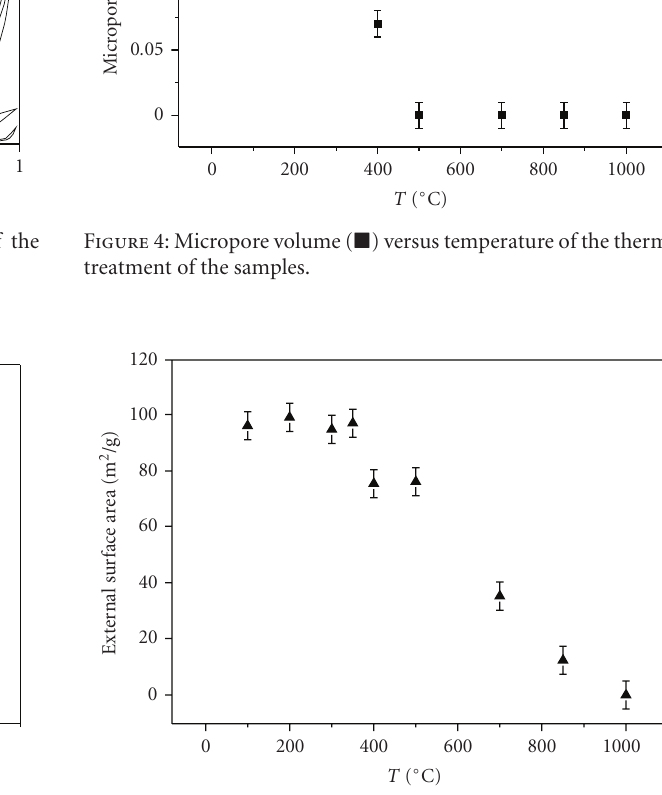
Figure 5: External surface area ( (cid:3) ) versus temperature of the thermal treatment of the